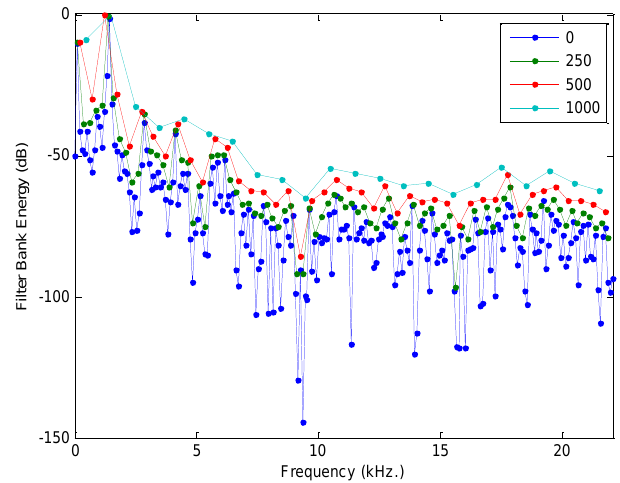
Figure 9. Filter Bank Energy (FBE) for a bank of rectangular filters with various bandwidths.